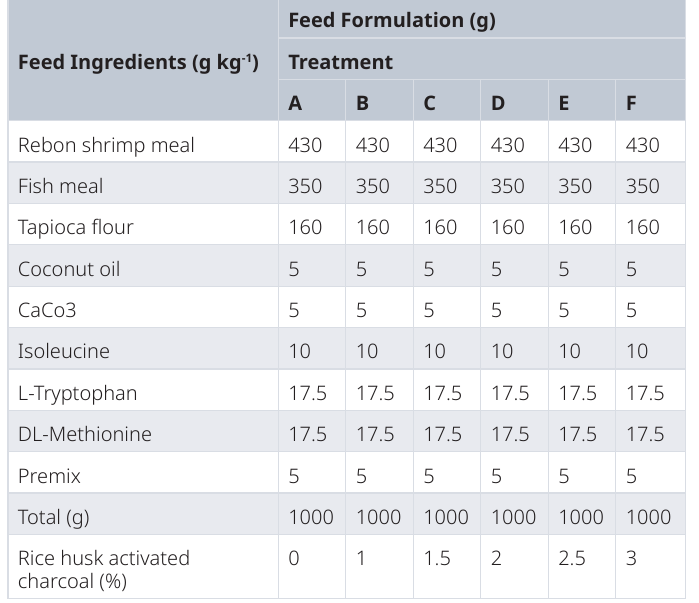
Table 1. Feed formulations (g kg − 1 ) with 50% protein content used in the research.